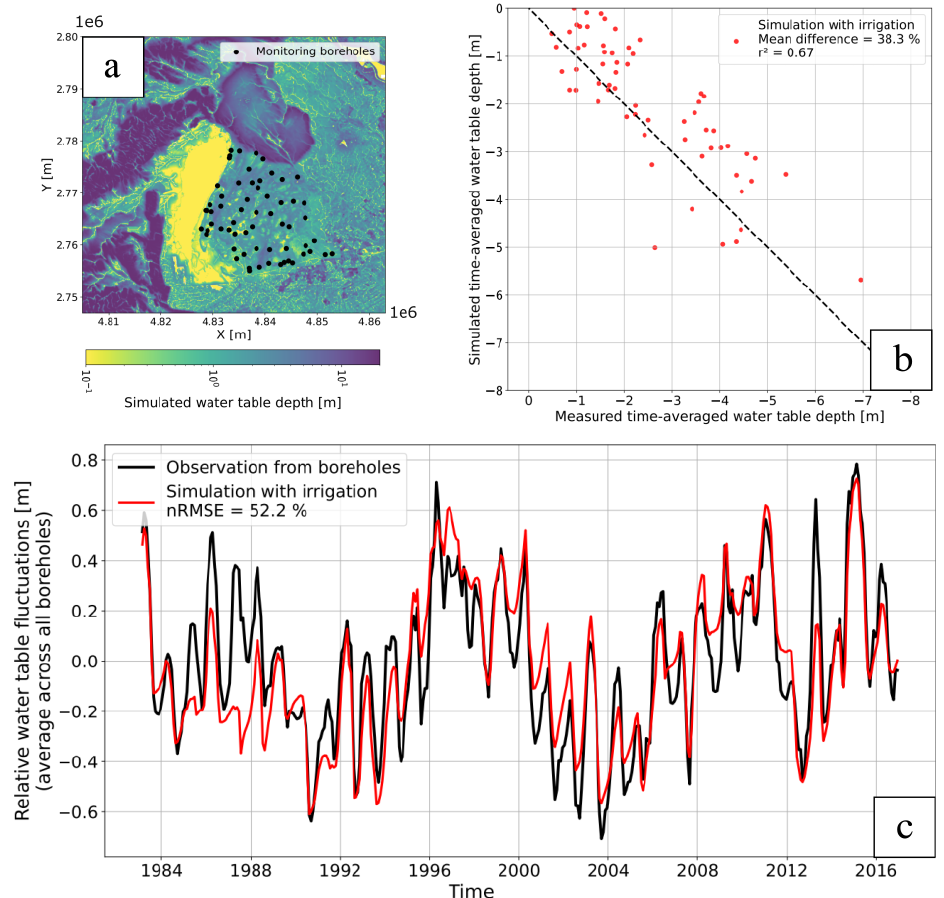
Figure 4. (a) Map of the monitoring boreholes in the Seewinkel region. (b) Comparison between observed and simulated time-averaged water table depth. (c) Comparison between monthly observed and simulated water table time fluctuations averaged across all monitoring boreholes and expressed as anomalies (relative to the time